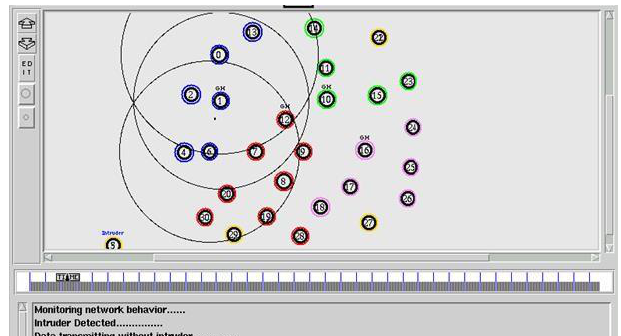
Figure 4 . Cloud service providers and consumers during runtime